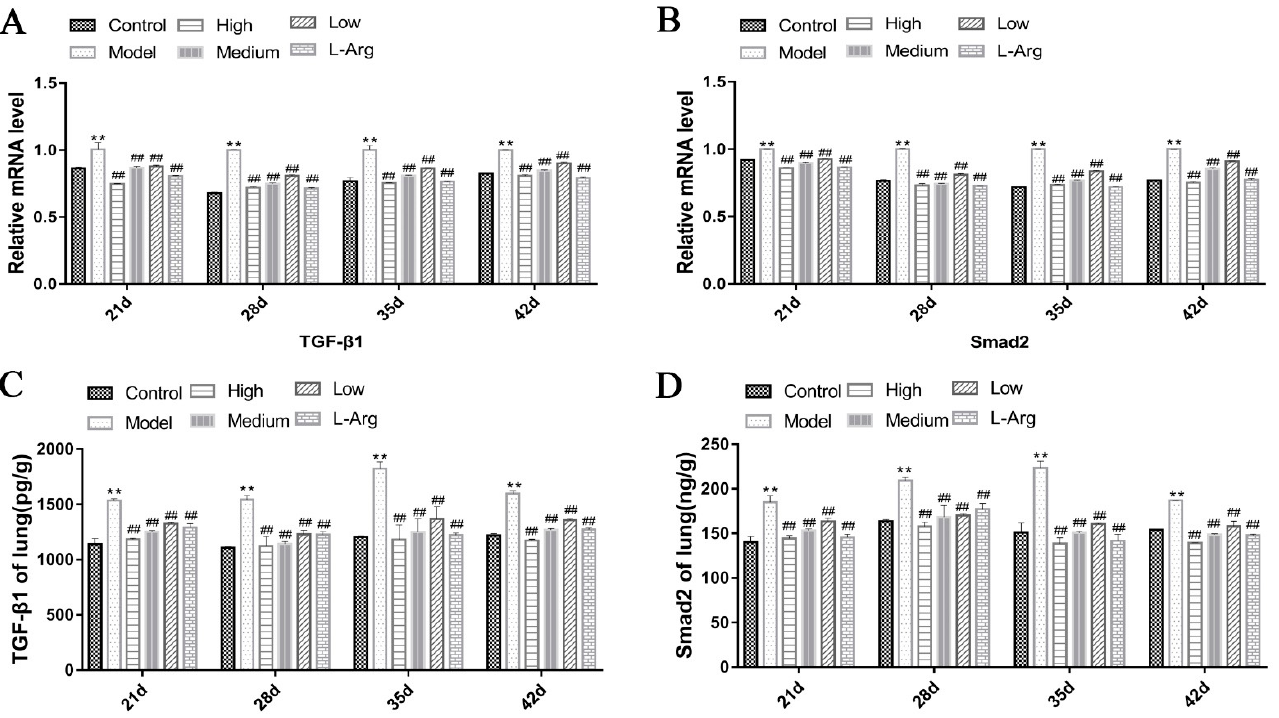
Figure 7. QLJP reduced the expression levels of TGF- β 1 and Smad2 in the lung. ( A ) Relative mRNA level of TGF- β 1 , ( B ) relative mRNA level of Smad2 , ( C ) the protein level of TGF- β 1, and ( D ) the protein level of Smad2. Data are expressed as the mean ± SEM, n = 5. ** p < 0.01, compared to the control group; ## p < 0.01, compared to the model group.